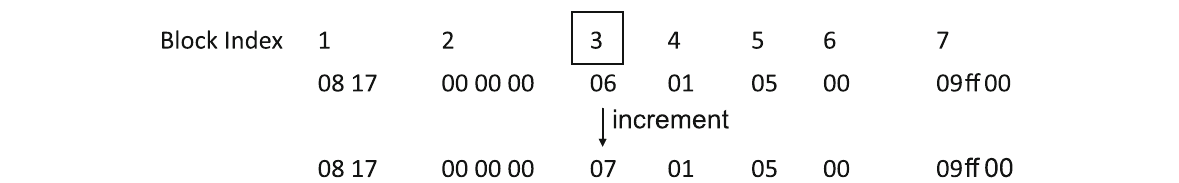
Fig. 9 The combination of the block number an the mutation method. When the block number is 3 and the mutation method is an increment, the value of the third block is chosen to be increased